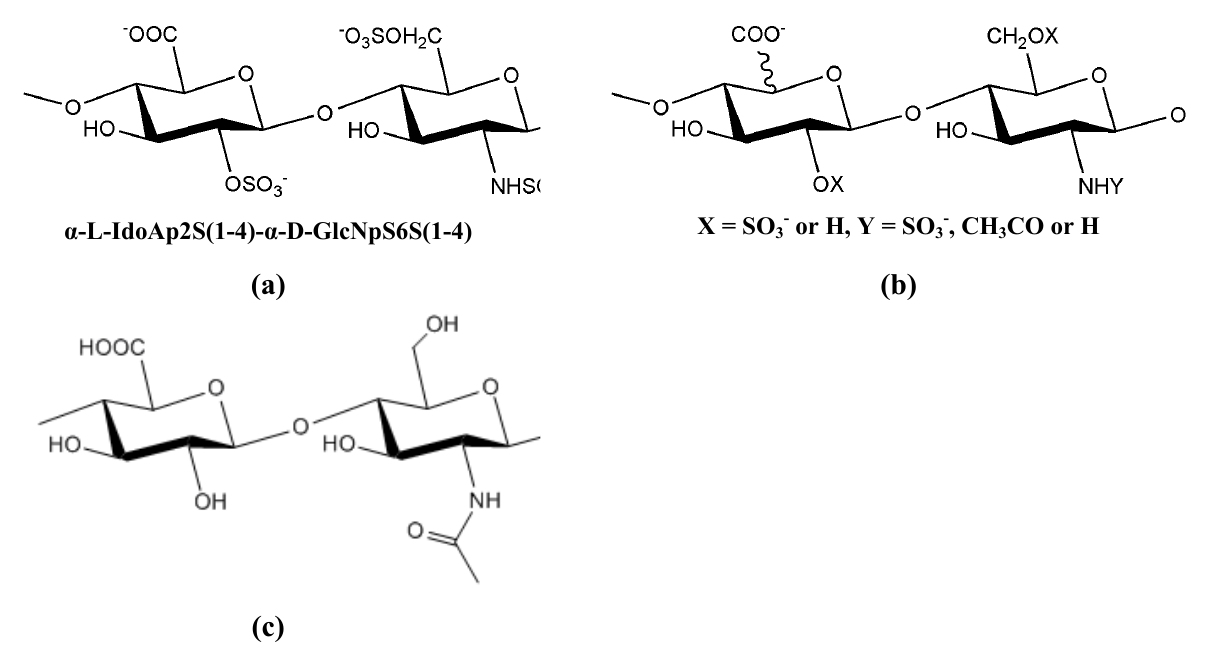
Figure 7. The structure of: (a) the major disaccharide sequence, (b) the minor disaccharide sequence of heparin and (c) the polysaccharide produced by E. coli [85].